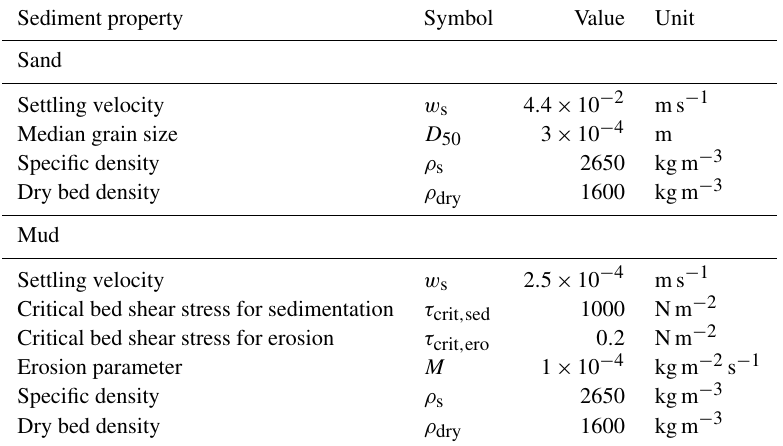
Table 1. Sediment characteristics applied in the default model. Variation in settling velocity will be discussed later as one of the sensitivity